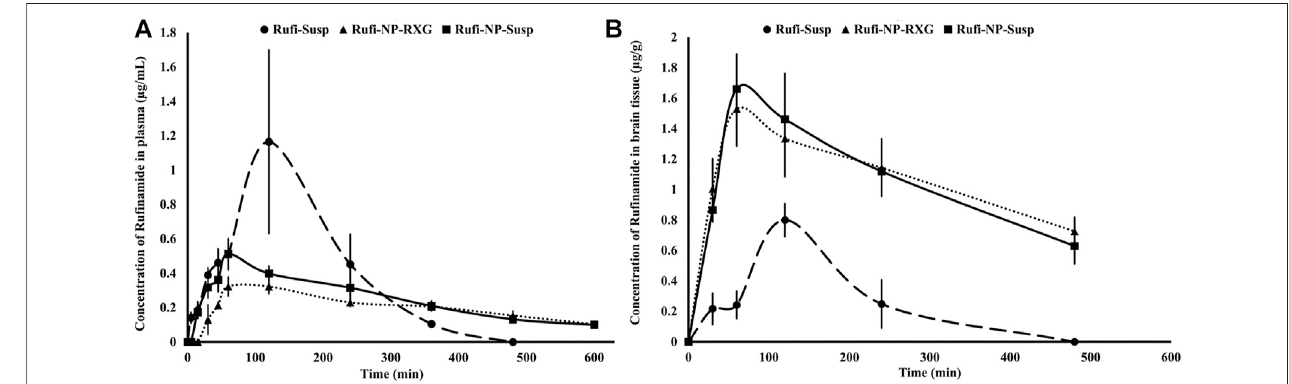
FIGURE 5 | Plasma and brain pharmacokinetic performance of formulations. (A) : Mean concentration time pro fi les of Ru fi namide obtained following intranasal administrationofRu fi -NP-Susp,Ru fi -NP-RXG,andRu fi -Suspinplasma; (B) :Meanconcentrationtimepro fi lesofRu fi namideobtainedfollowingintranasaladministration of Ru fi -NP-Susp, Ru fi -NP-RXG, and Ru fi -Susp in the brain. Note: Each data point is a representation of mean ± SD of n (cid:2) 4 animals for plasma PK, and for brain PK n (cid:2) 4 animals were used at every time point.